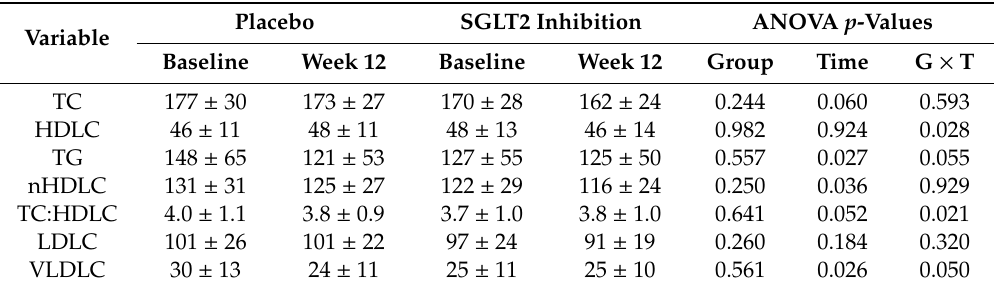
Table 4. Lipid profile prior to and following 12 weeks of dietary counselling for weight loss supplemented with placebo or SGLT2 inhibition.